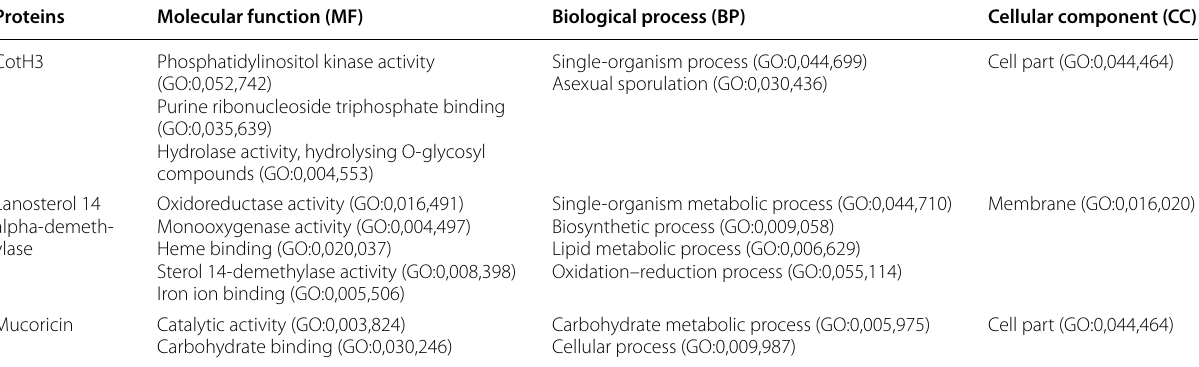
Table 1 Predicted gene ontology (GO) terms by CI-TASSER Proteins Molecular function (MF) Biological process (BP) CotH3